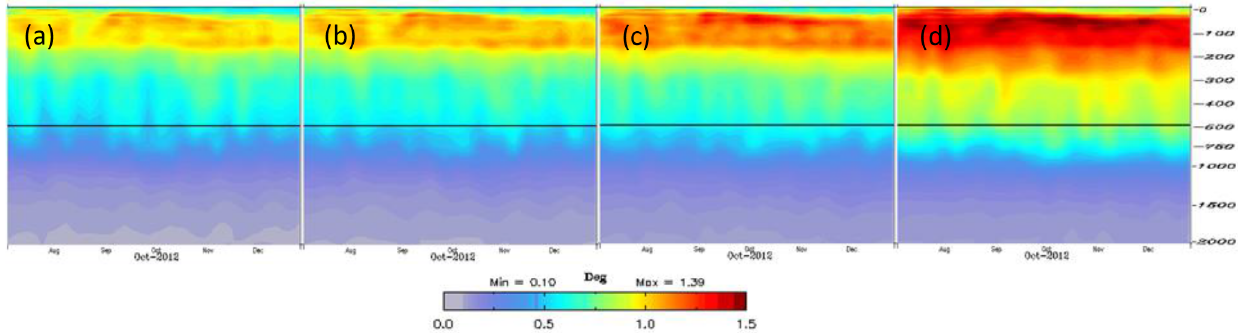
Figure 13. RMS time series of the temperature innovations for Run-Ref (a) , Run-Argo2 (b) , Run-NoArgo (c) and Free Run (d) in the last 6 months of the experiments.